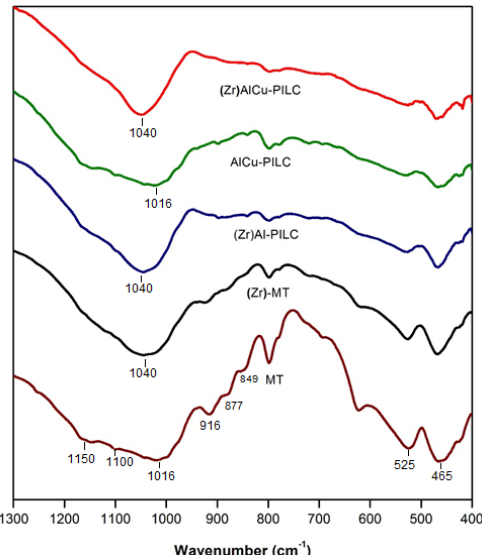
Figure 2. FTIR results obtained before (MT) and after pillaring process (AlCu-PILC) and Zr-dopage ((Zr)-Al-PILC, (Zr)AlCu-PILC), Zr-MT.